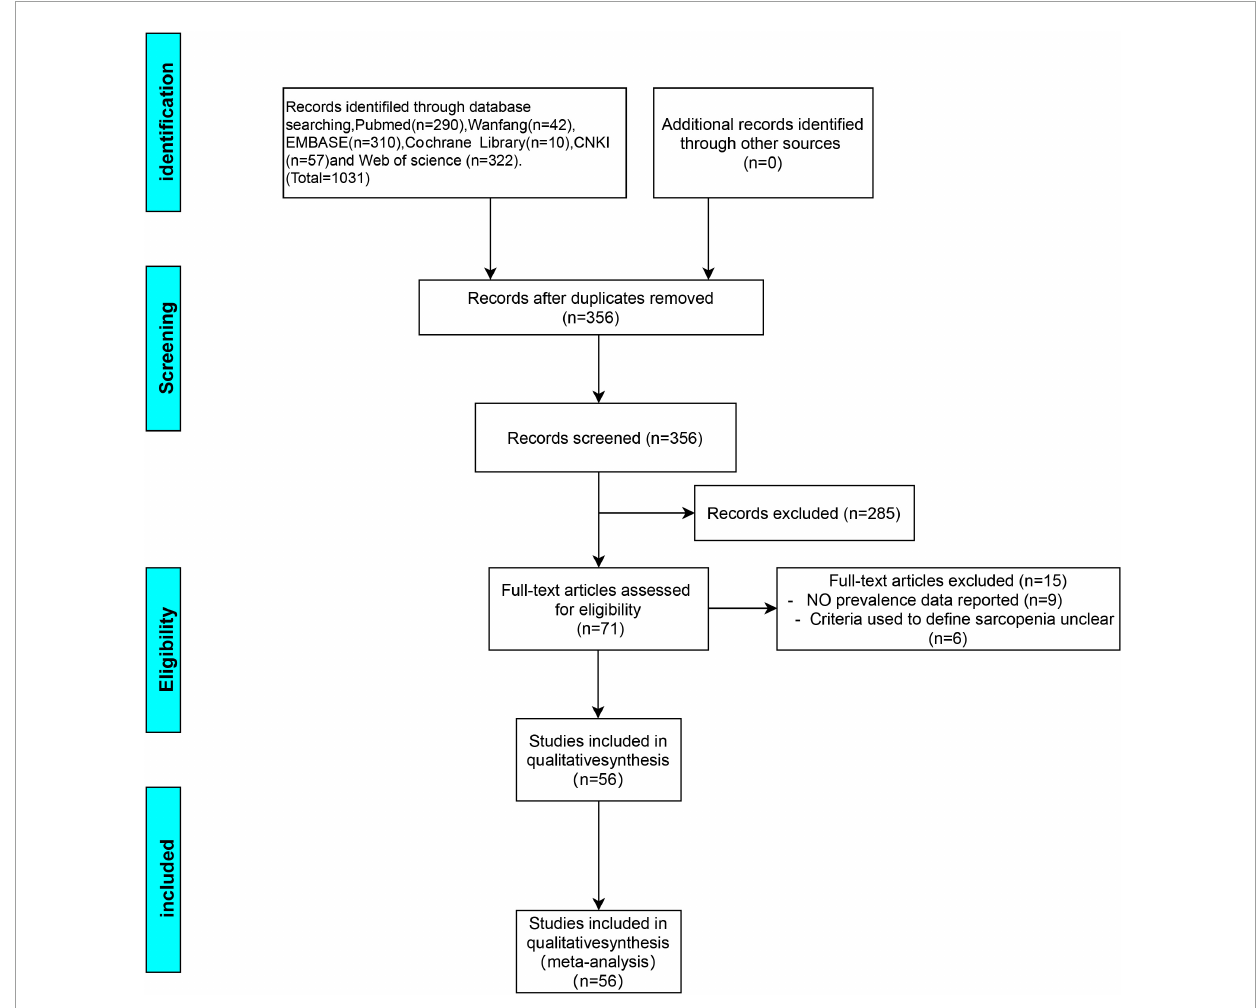
FIGURE1 Preferred reporting item for meta-analysis (PRISMA) flow diagram for the study selection